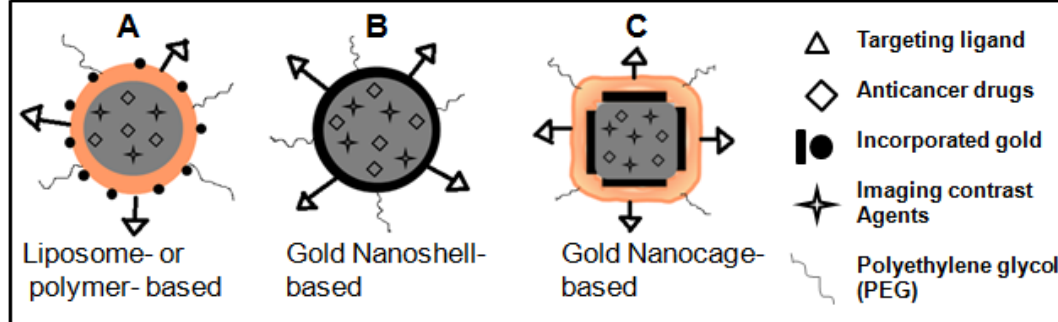
Figure 12. Future generation multifunctional NPs for improved therapeutics and